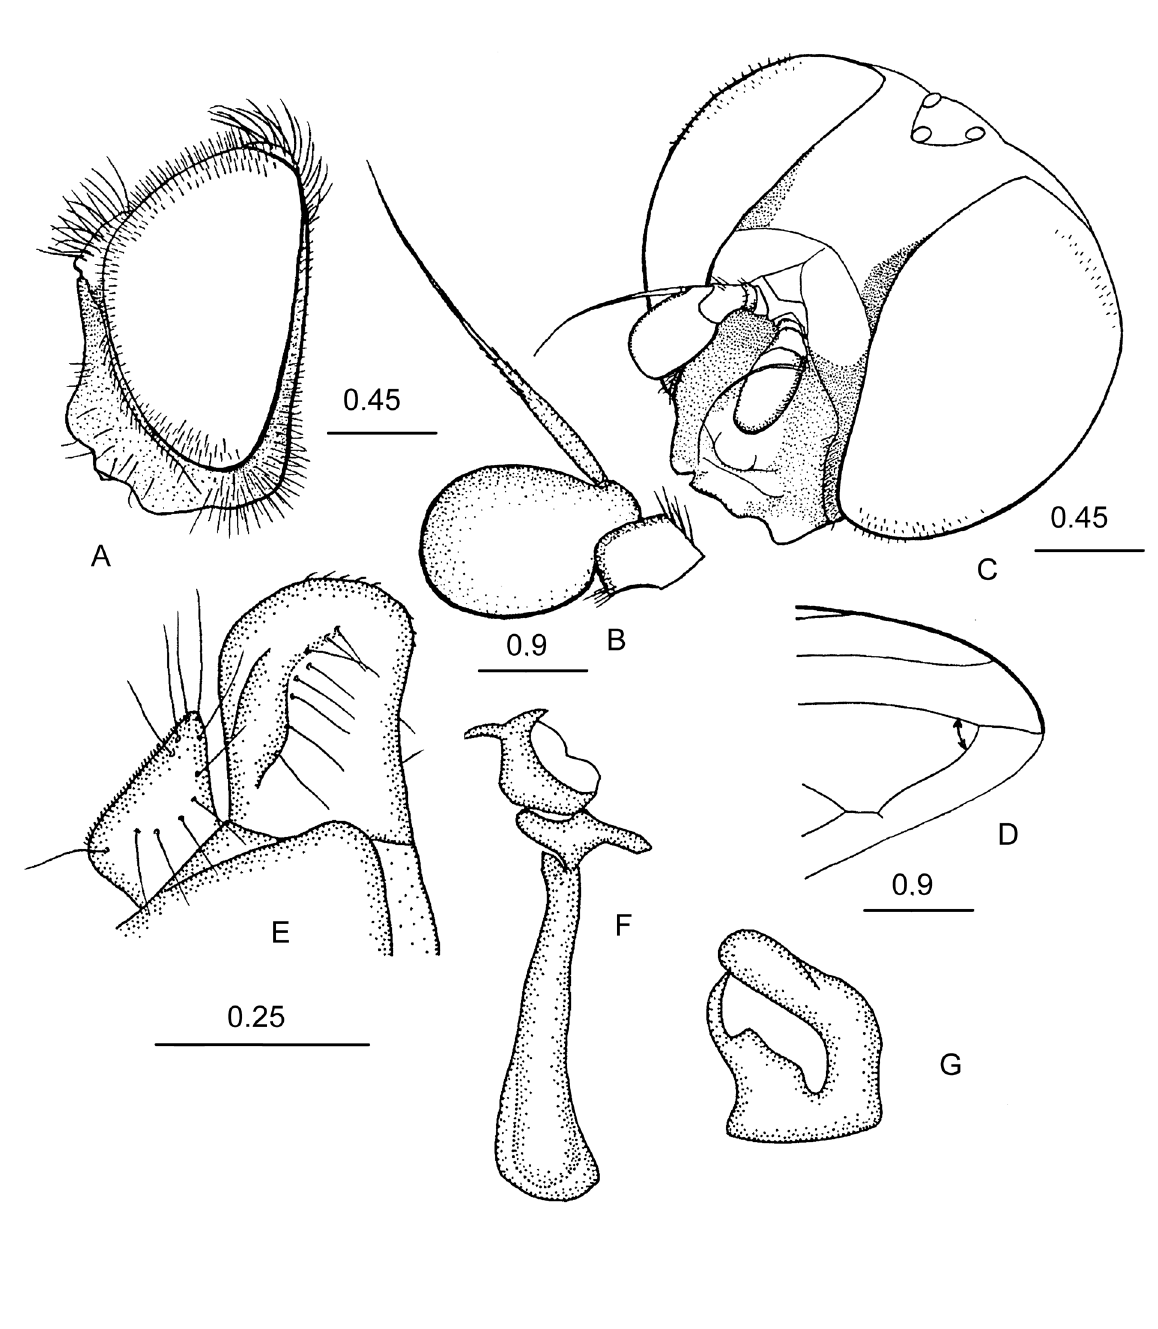
Fig. 13. Cheilosia ( Cheilosia ) difficilis Hervé-Bazin, 1929. A . Head of ♂, lateral view. B . Antenna of ♂, lateral view of pedicel and basoflagellomere. C . Head of ♀, antero-dorsal view. D . Tip of wing. E . Surstylus and gonocercus, lateral view. F . Aedeagus and aedeagal apodeme, lateral view. G . Superior lobe of hypandrium, lateral view. Scale bars indicated in